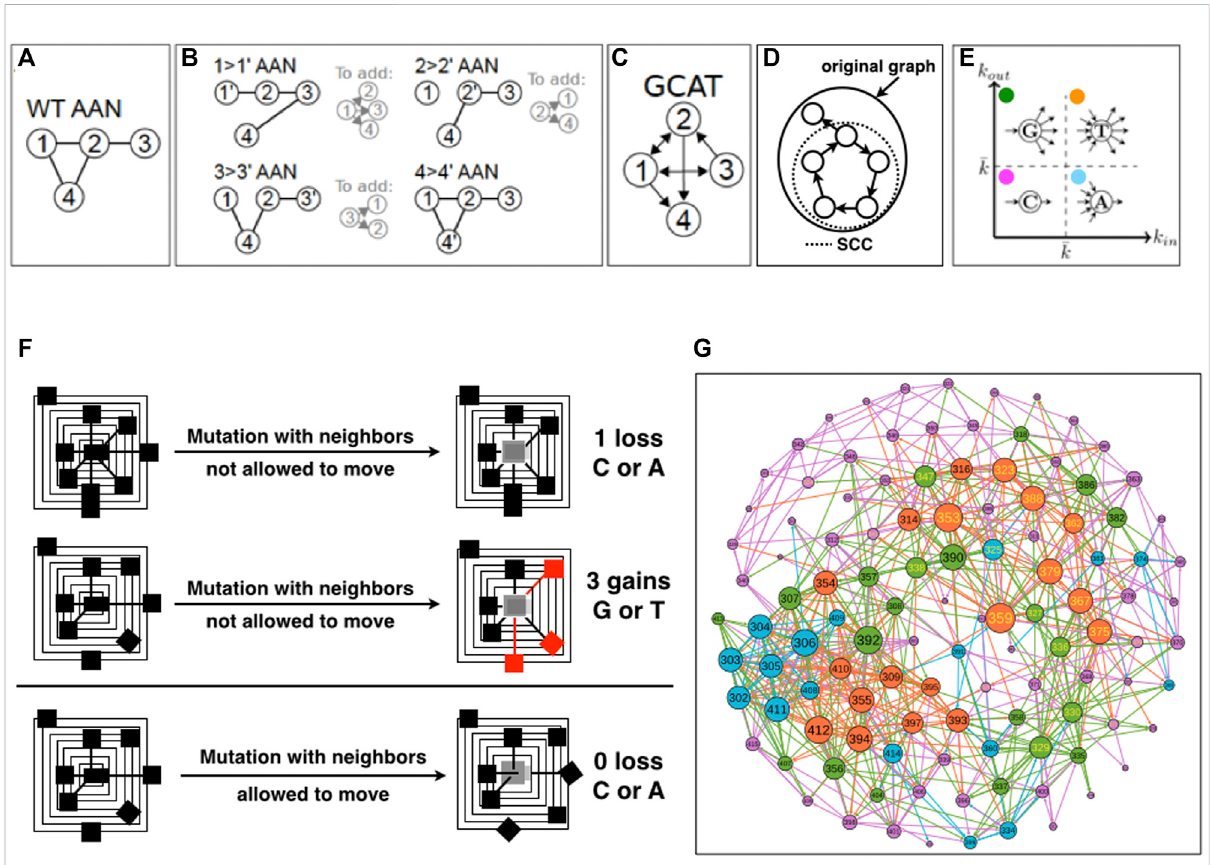
FIGURE 1 SchematicsoftheconstructionoftheGCATnetwork. (A) .TheAminoAcidNetwork(AAN)ofthewild-typeproteiniscreated.Nodescorrespond to amino acids and are named by the position in the amino-acid sequence of the protein. (B) . The AAN of mutants are created. For each amino acid (i.e.,eachnodeoftheAAN),theAANofallits19mutantsiscreated.Foreachmutationi- > i ’ ,ifanaminoacidjhaschangedamino-acidneighborhood inthemutant ’ sAANcomparedtotheWTAAN,thenanedgefromthemutationsite i to j isaddedintheGCATnetwork.Here,onlyonemutation per amino acid is represented, for simplicity. (C) . The resulting GCAT network. (D) . Schematic of the strongly connected component (SCC) of a directed graph. (E) . Classi fi cation of nodes as G (Generate), C (Connect), A (Absorb) and T (Transmit) in the GCAT network, based on the in- and out- degree. (F) . Schematics of neighborhood changes upon in silico mutation. (G) . The GCAT network of